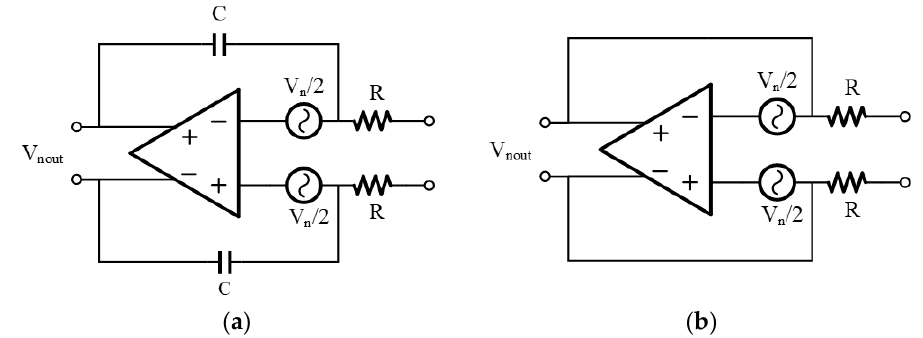
Figure 5. Noise analysis of the DC-servo loop (DSL) circuit: ( a ) complete version, ( b ) simplified version.